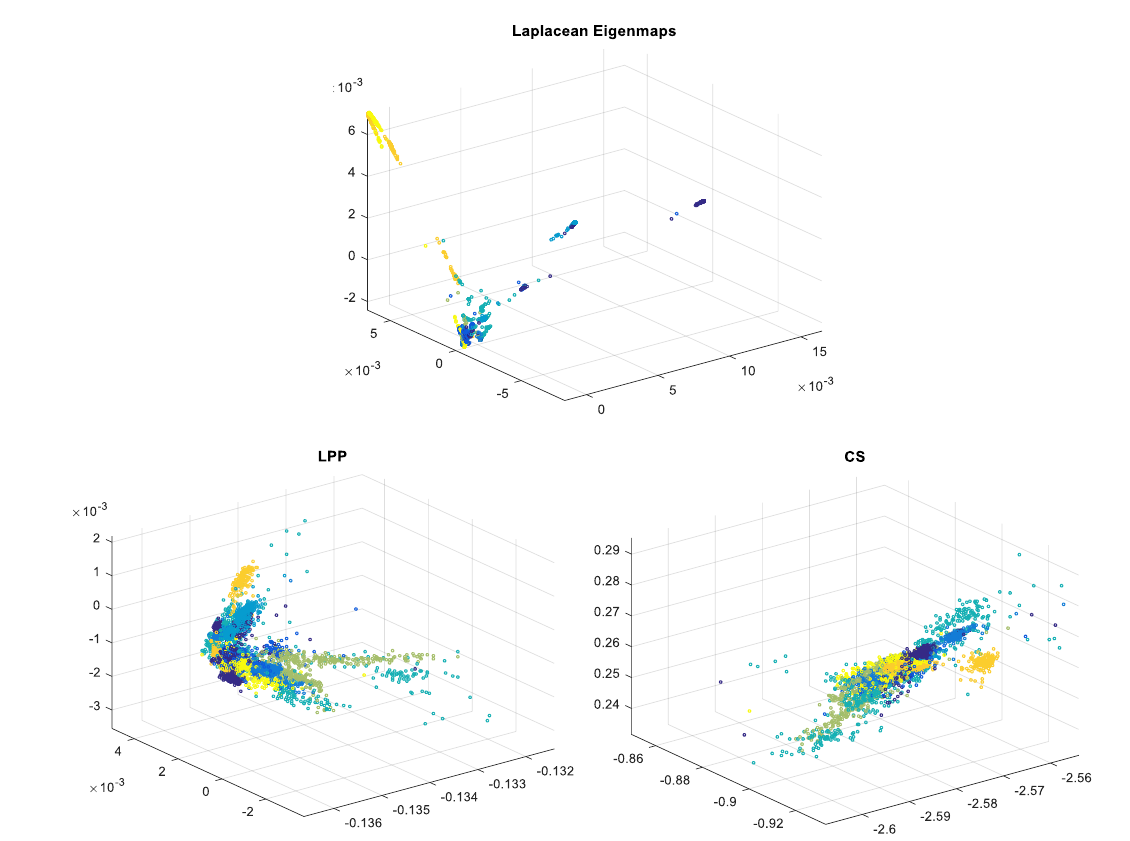
Figure 7. ECG data mapped into a 3-dimensional space with LE, LPP and CS